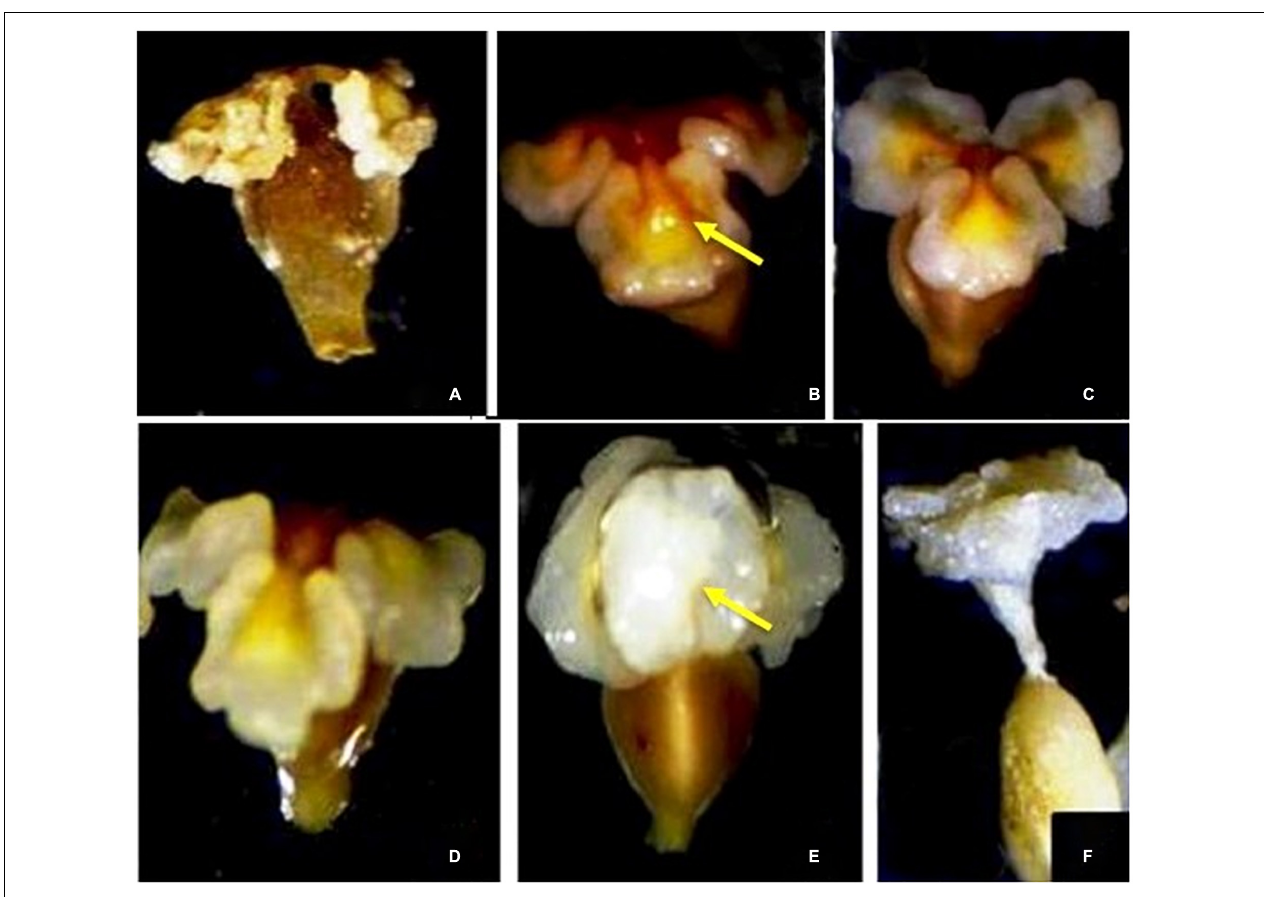
FIGURE 5 | (A–F) Stigma-stylar movement in Rheum